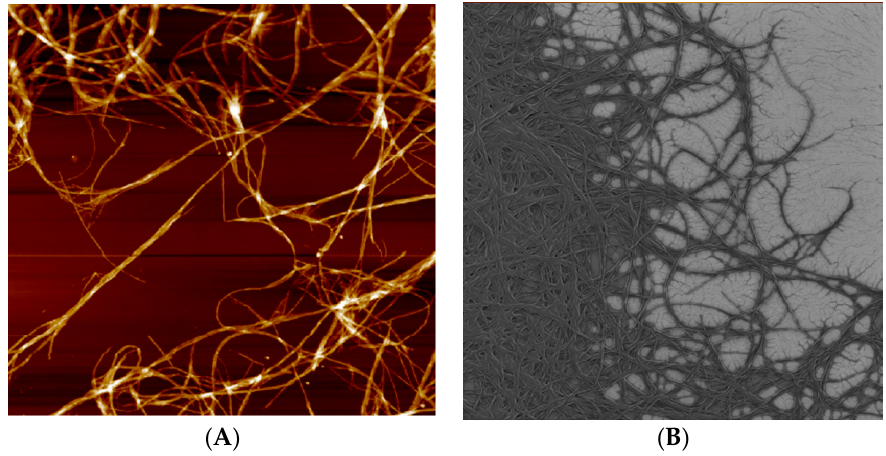
Figure 7. AFM ( A ); and SEM ( B ) images of DNA in complexes with Ag–Phen on silicon. Fixation was carried out from DNA solution in 0.005 M NaNO 3 at C (DNA) = 0.005% and C (Ag–Phen) = 4.5 × 10 − 4 M; Images have a size 5 μ m × 5 μ m.